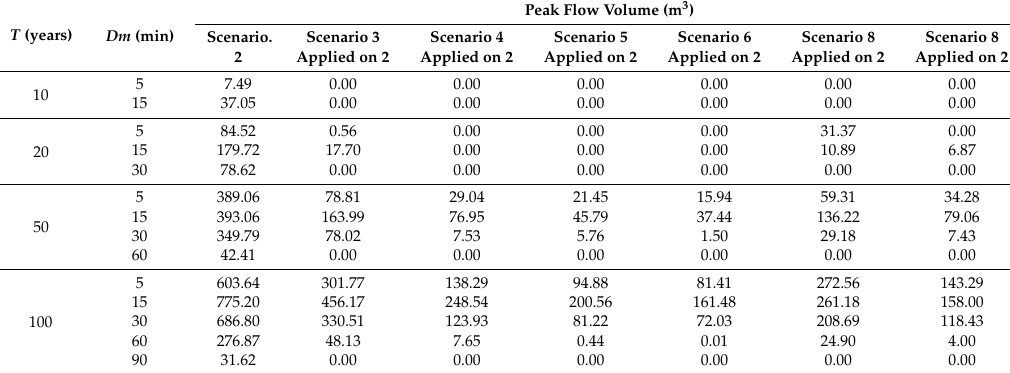
Table 11. Peak flow volumes based on the Scenario 2, recorded in the area that drains to the discharge point